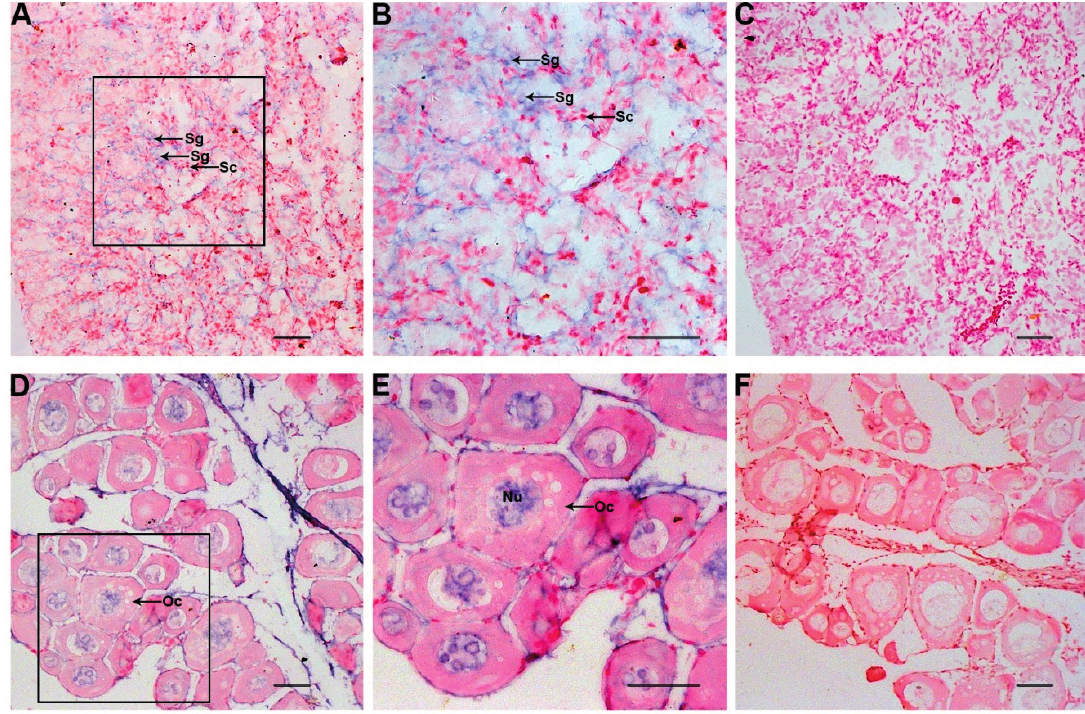
Figure 9. Expression of Po-prdm14 mRNA in the gonads analyzed by in situ hybridization and histology. The Po-prdm14 mRNA-positive cells ( A , B , D , E ) were stained as purple or blue, whereas the negative control with sense probe hybridization ( C , F ) was unstained. The box indicates the area magnified in the next frame ( A , C , D , F : 20×; B , E : 40×). The Po-prdm14 mRNA transcripts were observed in the spermatogonia, but no signals were detected in the spermatocytes in the testis ( A , B ). Noticeable positive signals were exhibited in the nucleus of oocytes in ovary ( D , E ). Sg, Spermatogonia; Sc, Spermatocytes; Oc, Oocytes; Nu, Nucleus. Scale bars, 25 μ